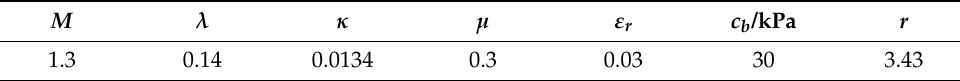
Table 5. Material parameters for Intact clayey loess.